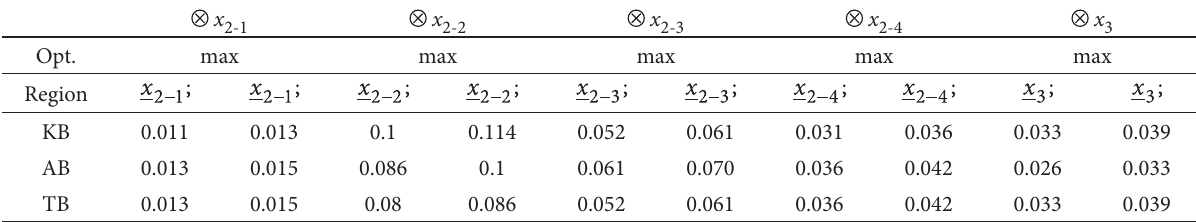
Table 10. (continuation). Normalized weighted decision making matrix x 2-1 Opt.